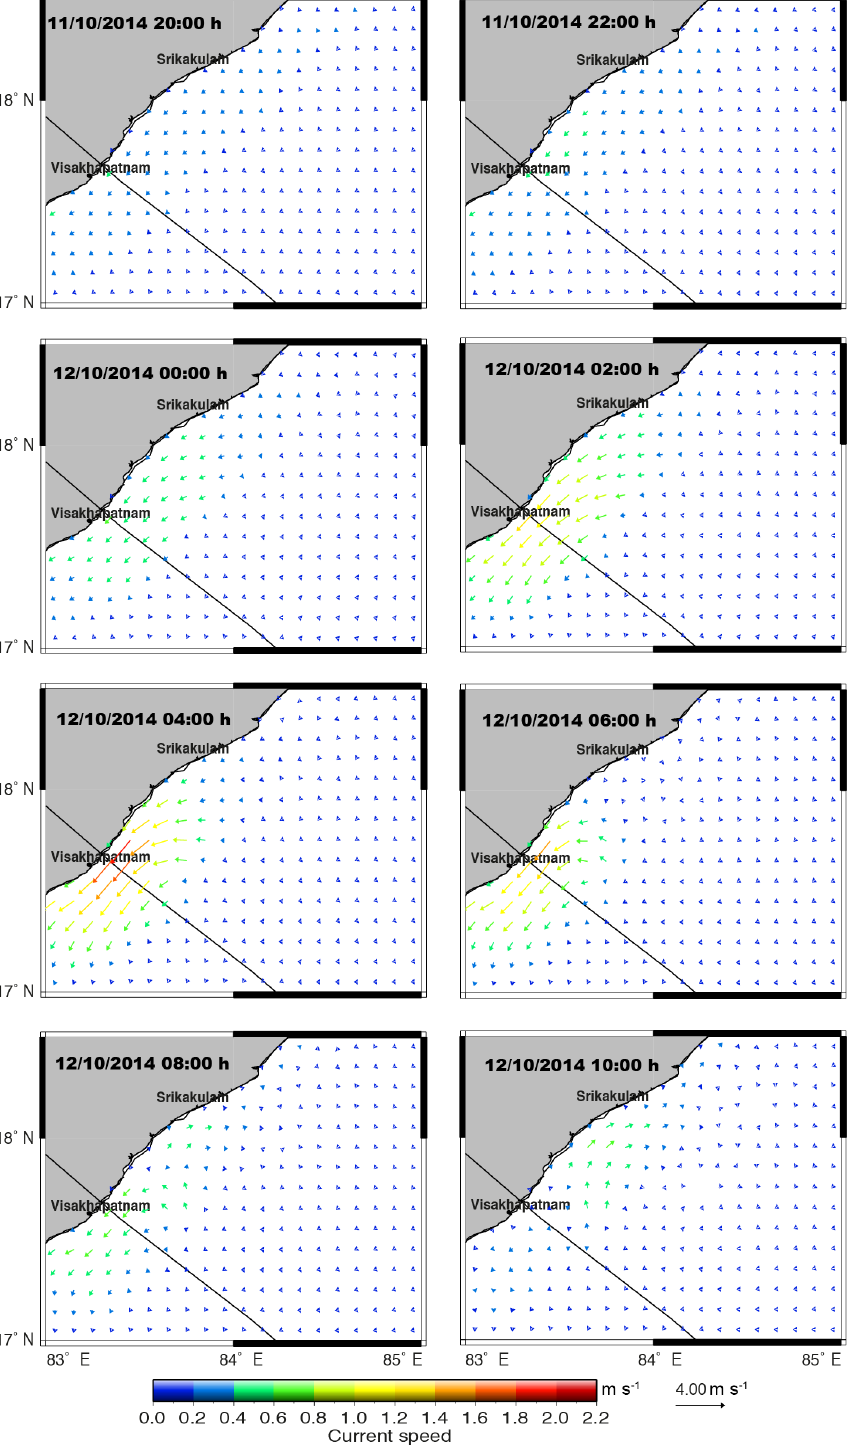
Figure 7. Current speed and direction simulated along the track of the Hudhud cyclone using the coupled ADCIRC + SWAN model (colour code represents current speed in metres per second; vectors represent current